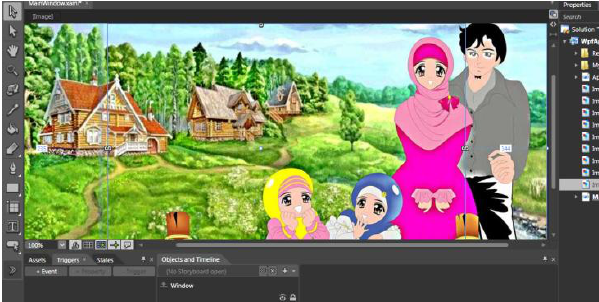
Figure VIII. Cultural mixed elements.